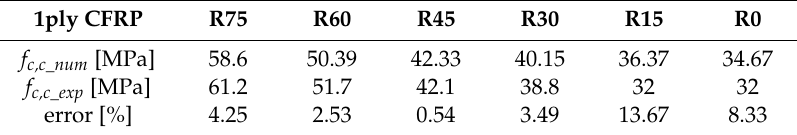
Table 2. Percentage error with respect to f c , c [MPa] from the experiments (1ply).